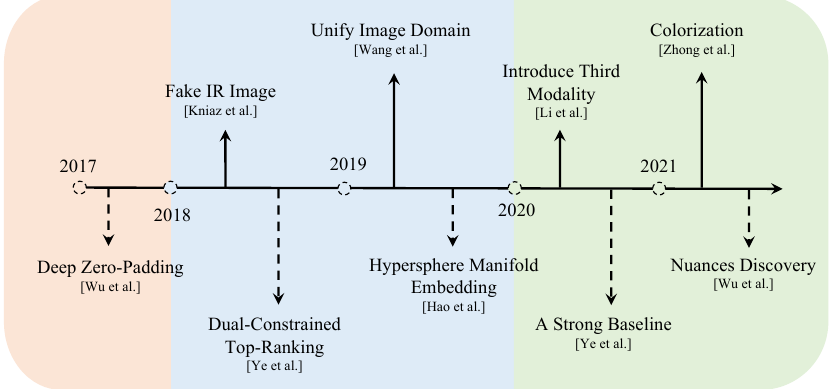
Figure 4. Milestones of existing methods of VI-ReID. Since the problem was proposed, researchers have proposed various methods to bridge the modality discrepancy. Note that the top row and bottom row denote a generative-based model and non-generative-based model,